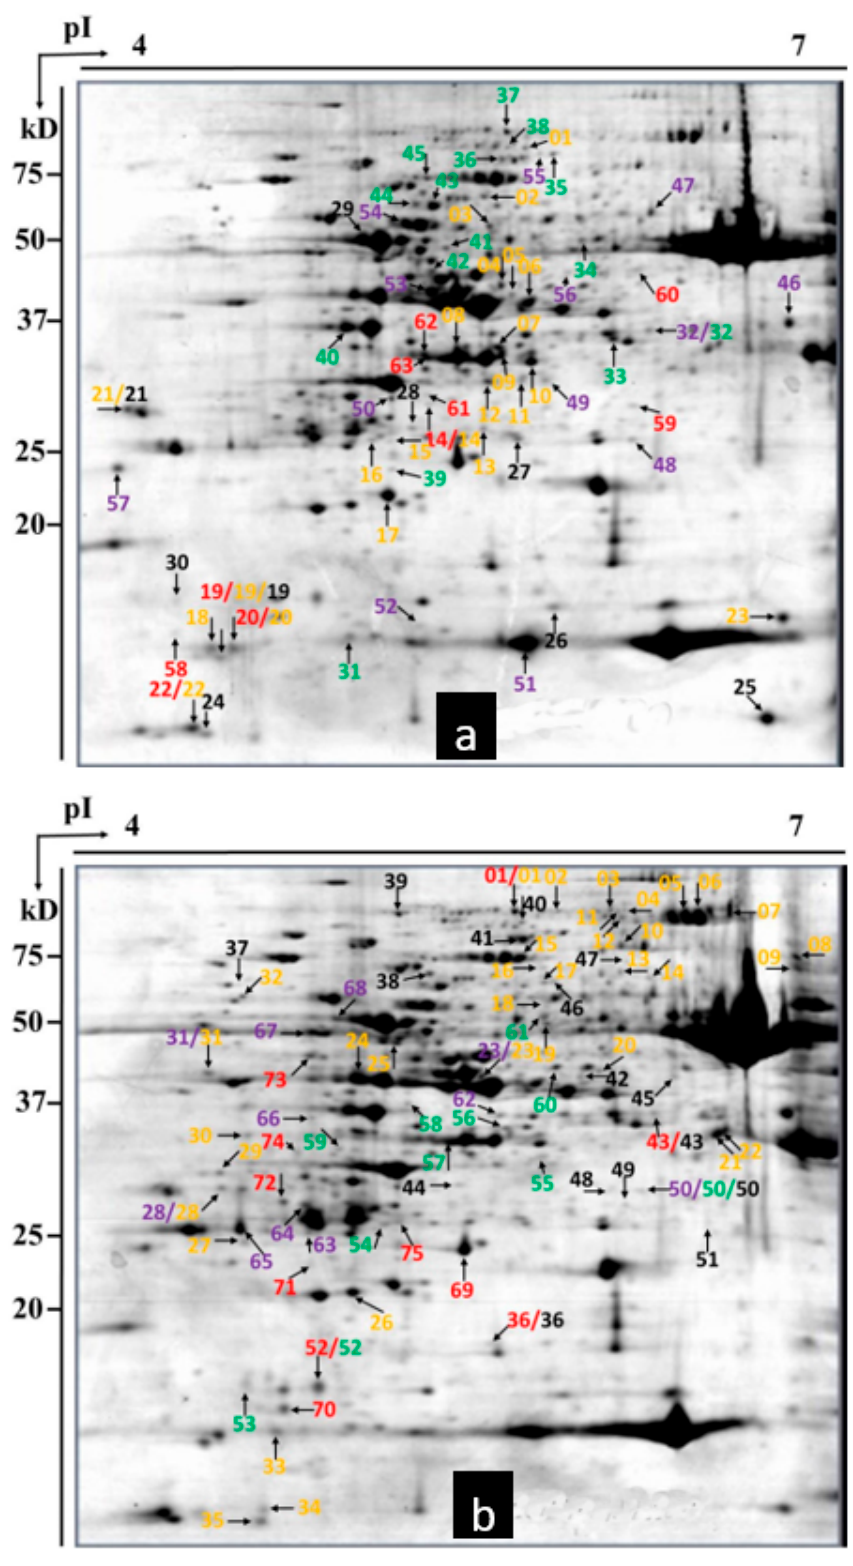
Figure 5. Differences in protein expression between resistant wheat cultivar Neimai836 wheat with and without powdery mildew infection. ( a ) Upregulated proteins are labeled in the representative 2-DE gel of Bgt -inoculated Neimai836 wheat at 12 hpi. ( b ) Downregulated proteins are labeled in the representative 2-DE gel of mock-inoculated Neimai836 wheat at 12 hpi. Red, 2 hpi; purple, 4 hpi; green, 8 hpi; yellow, 12 hpi; black, 24 hpi.